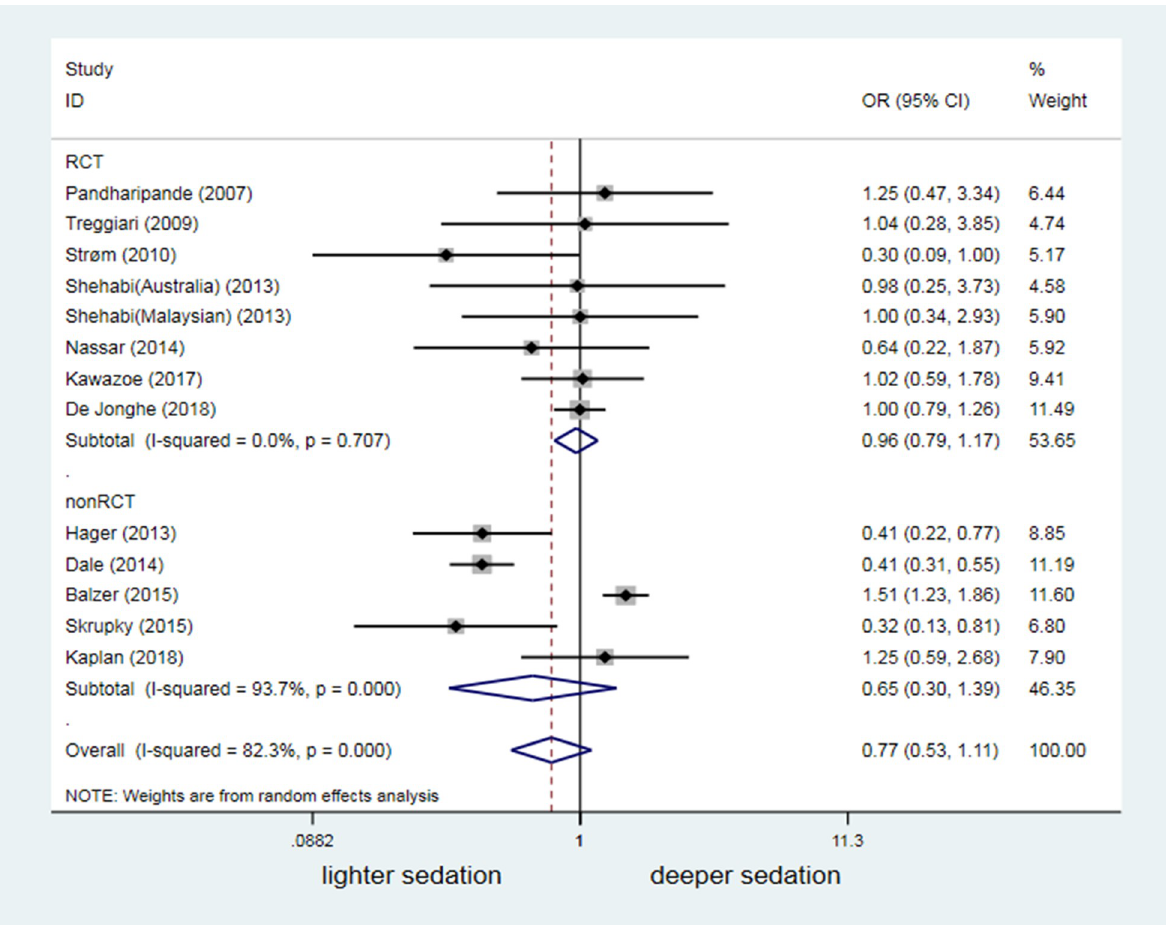
Fig 5. Confounding effect of different BZD dosage on results of different sedation depth affecting occurrence of delirium. BZD = Benzodiazepines.